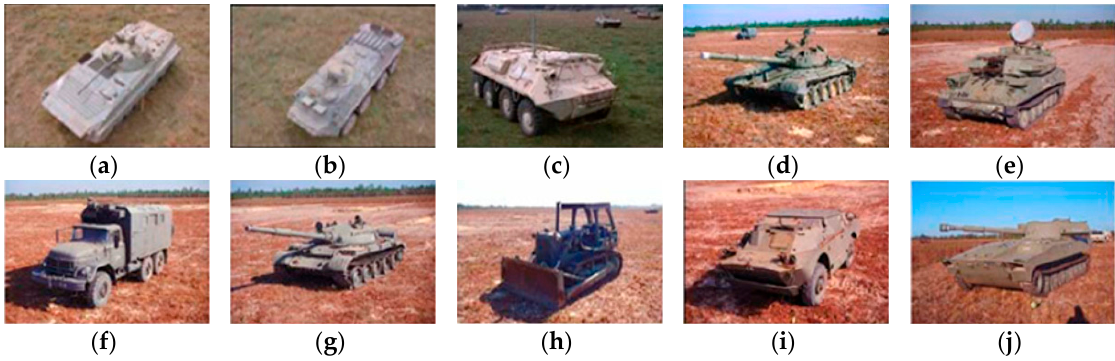
Figure 13. Optical images of ten targets. ( a ) BMP2; ( b ) BTR70; ( c ) BTR60; ( d ) T72; ( e ) ZSU; ( f ) ZIL; ( g )